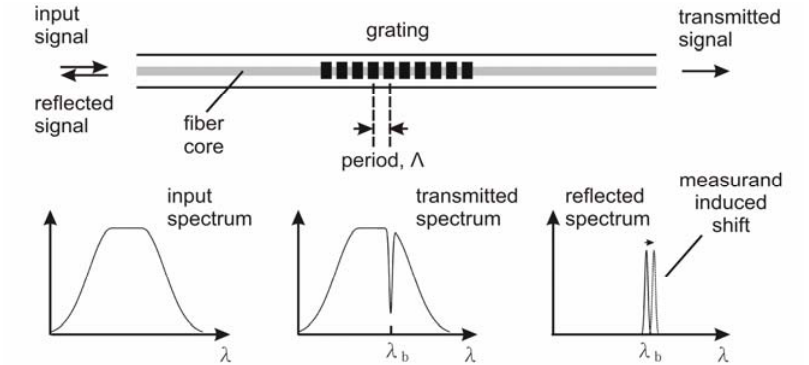
Figure 1. Mechanism of a Bragg grating-based sensing system [27].